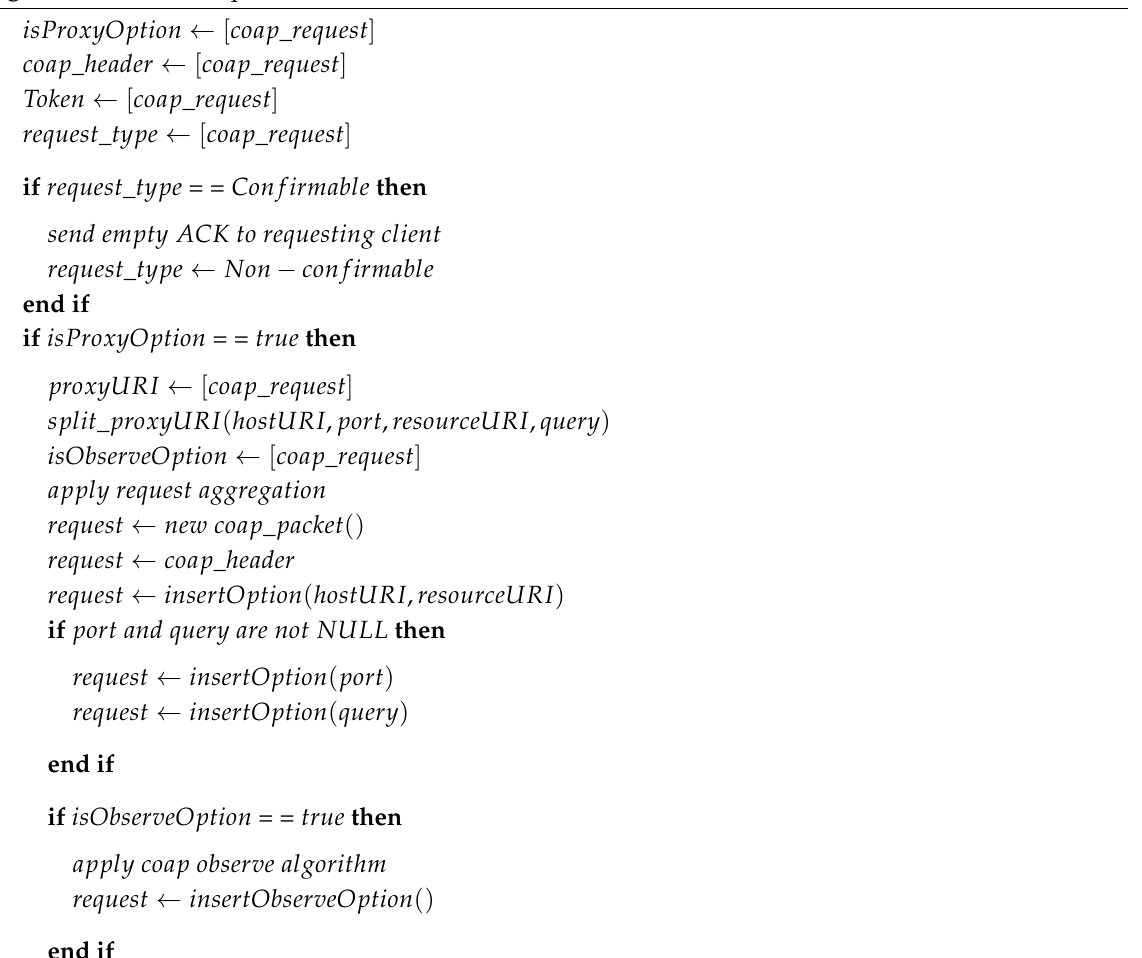
Algorithm 1 CoAP Request in